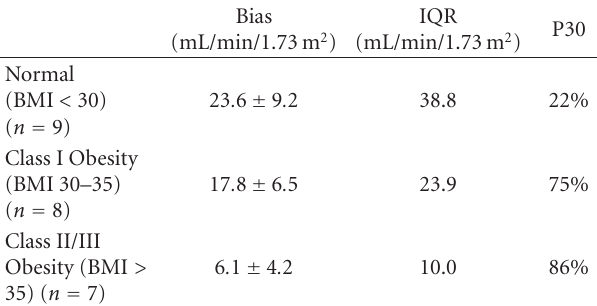
Table 3: Performance of 24-hour creatinine